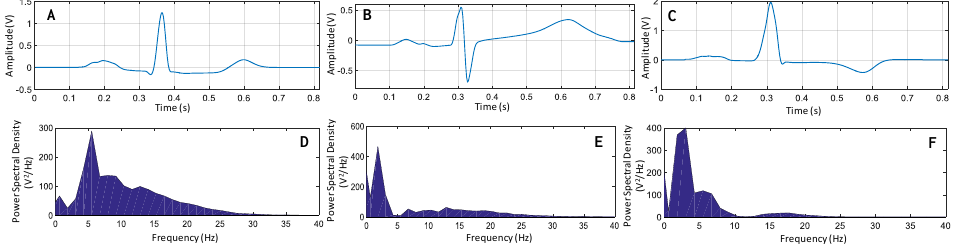
Figure 10. ECG trace averaged over traces and its power spectral density for ( A and D ) normal, ( B and E ) ST-elevation, and ( C and F ) T-wave inversion, respectively. Features Extraction: The power spectral of the signal in Figure 10D,E,F shows that the power spectral density peaks appeared at different frequencies for normal and abnormal ECG signals.